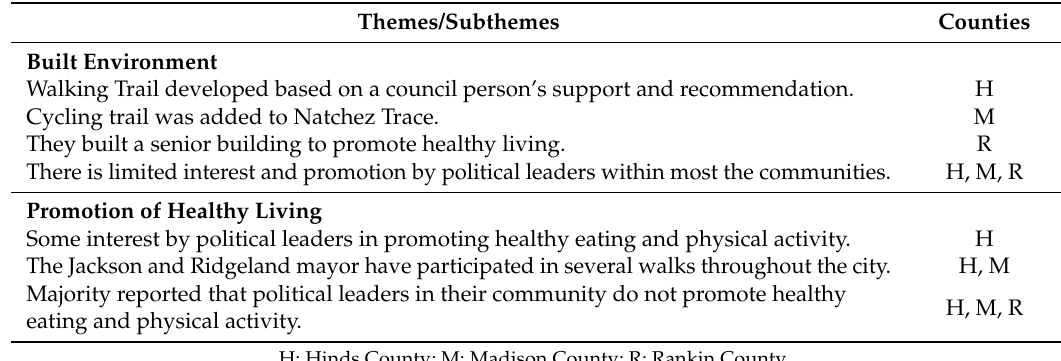
Table 2. Community members’ perception of political leaders’ involvement in healthy